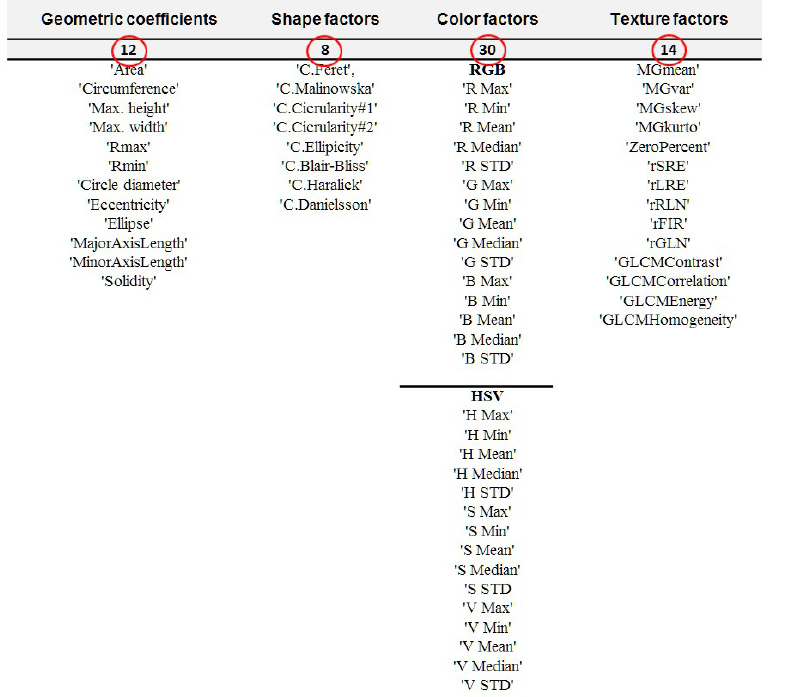
Figure 5. Specification of the barley varieties.